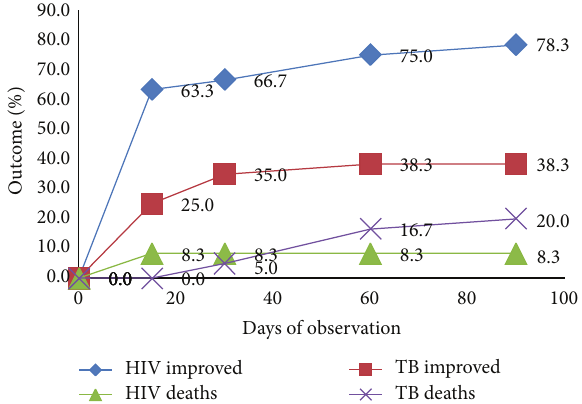
Figure 2: Cumulative percentages of the measured indicators in HIV-alone and TB/HIV groups. The difference is statistically significant ( 𝑃 < 0.05